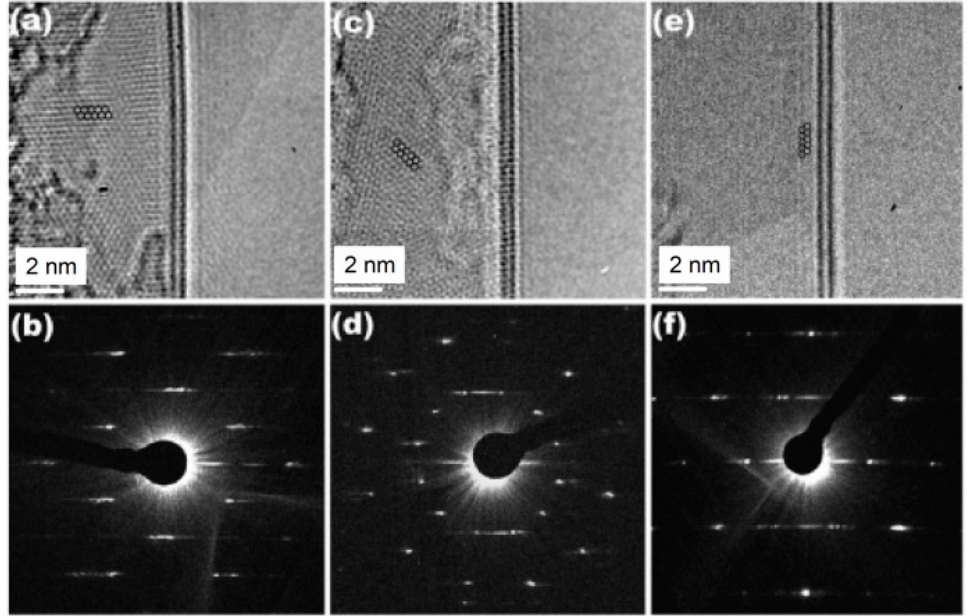
Figure 30. ( a – c ) HRTEM images and ( d – f ) ED patterns from bilayer graphene folded edges of armchair-type, 14.6° chiral folded-edge, zigzag-type, respectively. Reproduced with permission from Zhang et al. [105]. Copyright APS Physics, 2009.